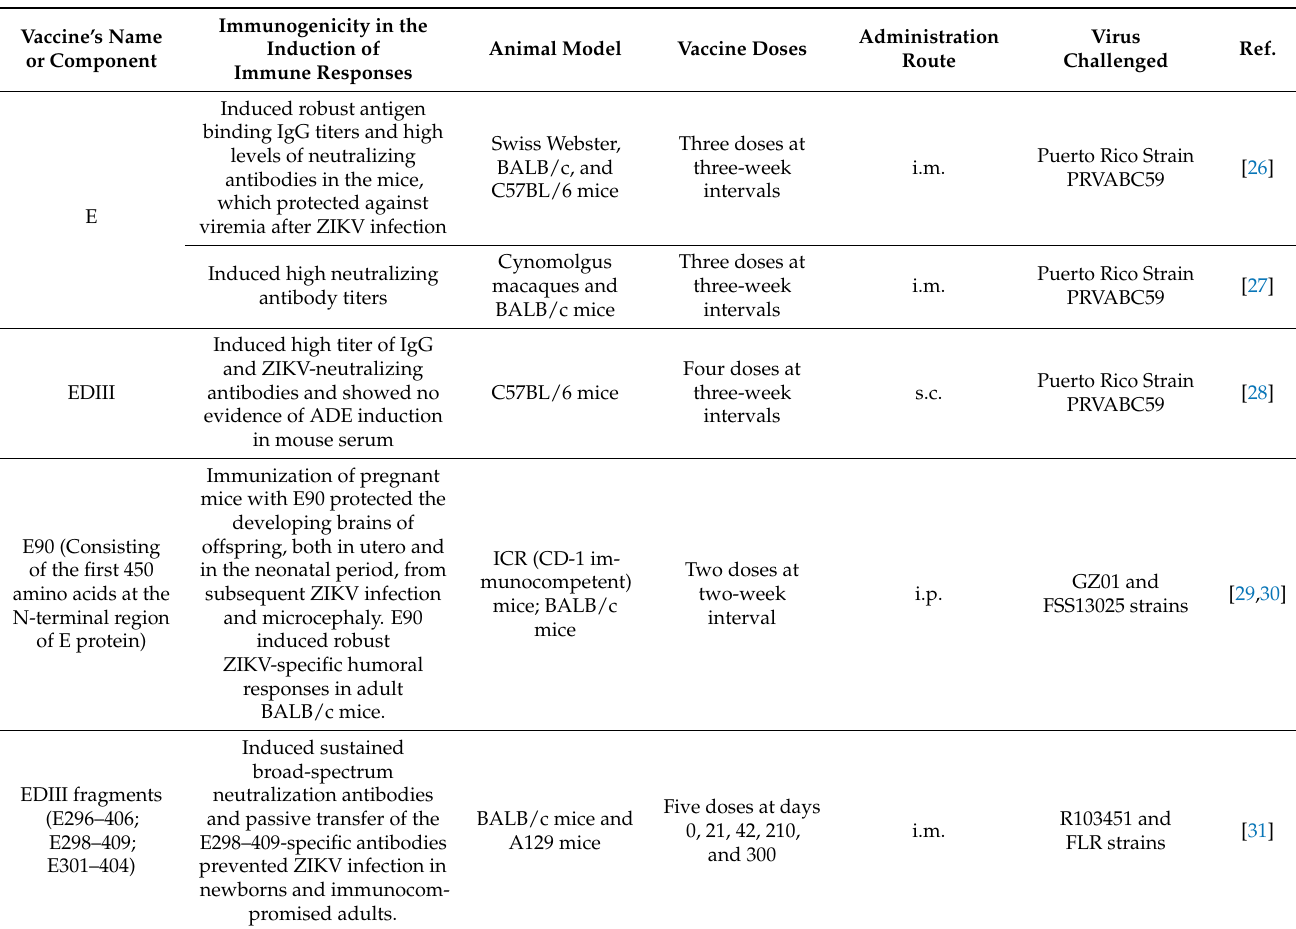
Table 2. Subunit vaccines against ZIKV